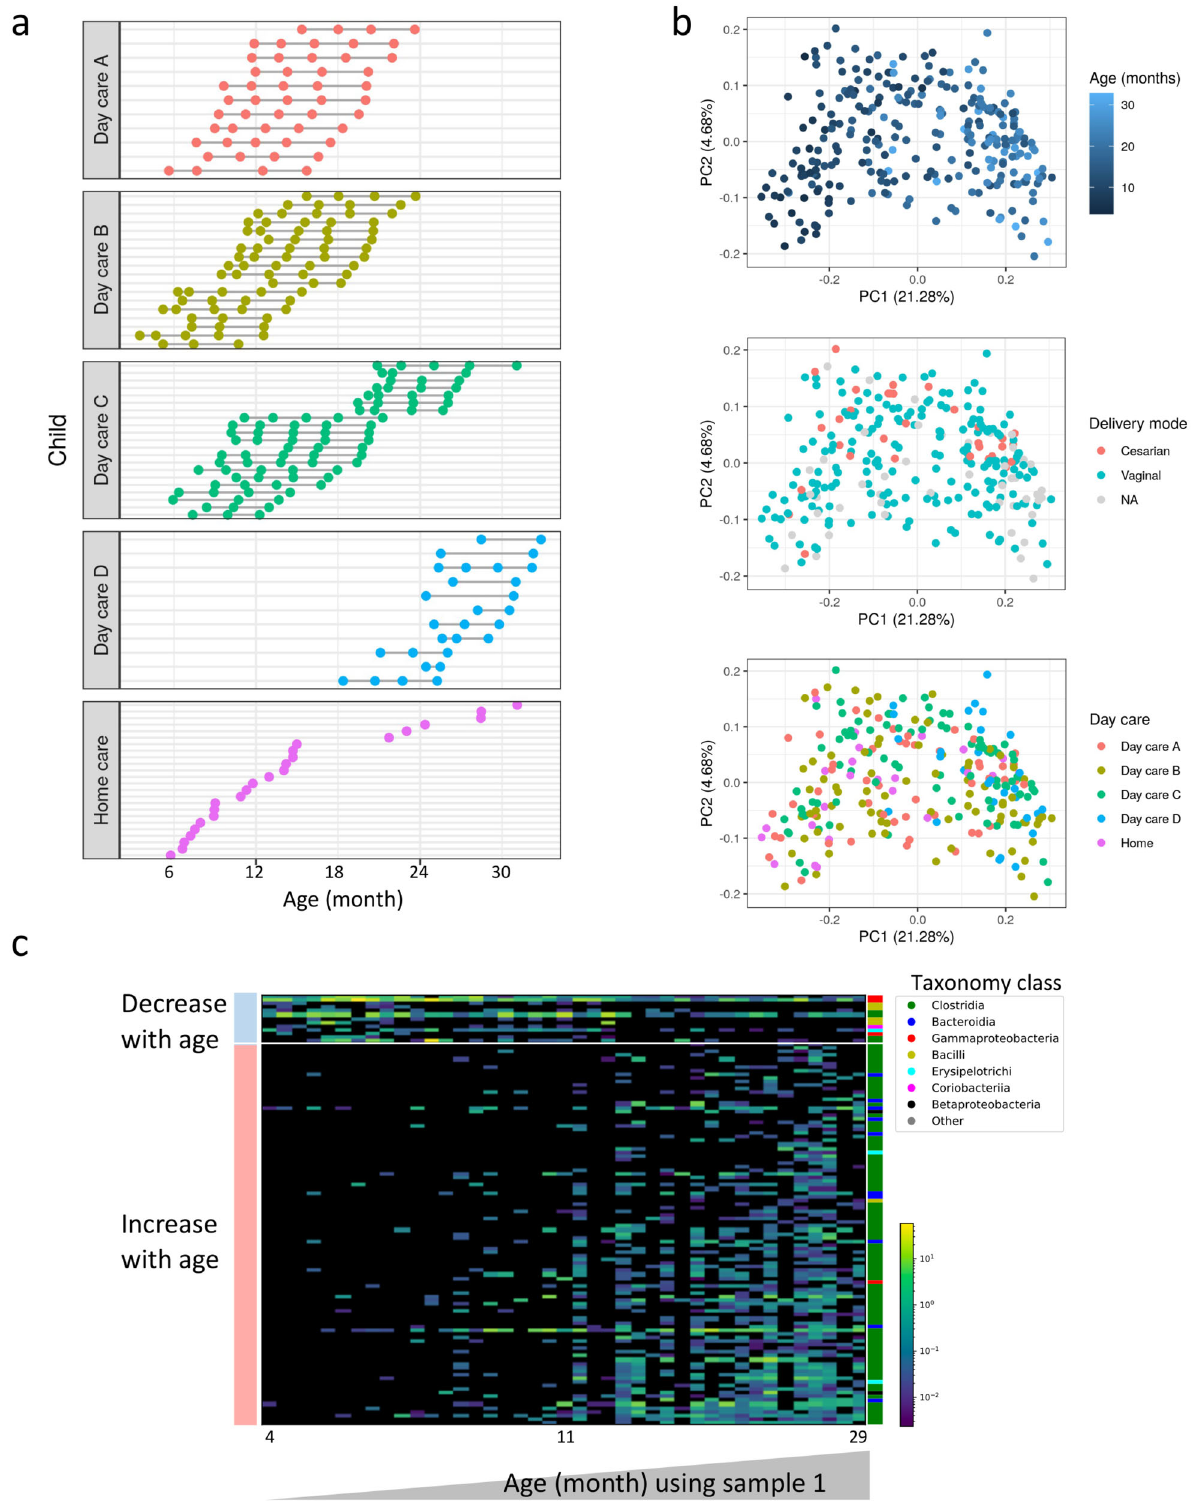
Fig. 1 Longitudinal cohort of 61 children starting day care, and additional age-match home care children. a Each row corresponds to an enrolled child with longitudinal fecal sampling. Stool samples were collected within the fi rst 2 weeks after each child started persistent day care attendance (sample or time point 1), and after 2 months (time point 2), 4 (time point 3), 7 (time point 4), and 10 months (time point 5) during the same school year. b Unweighted UniFrac PCoA plots colored by age, mode of delivery, and day care or home care of the 268 samples included in our study. c A heatmap representing 116 amplicon sequence variants (ASVs) that showed signi fi cant correlation with age in day care children using the fi rst sample obtained within the fi rst 2 weeks after each child started persistent day care attendance (Spearman correlation r > 0.3, dsFDR < 0.1). Each row represents a different ASV and each column a different sample. Samples are ordered by age, ASVs ordered by the effect size, color bar on the right indicates ASVs taxonomy class. Source data are provided as a Source Data fi